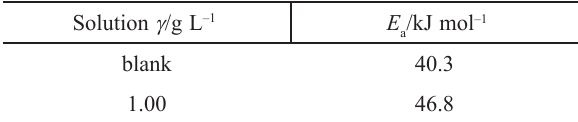
Table 6 – Activation energy for Cu in simulated acid rain in the presence and absence of HI extract Solution g /g L